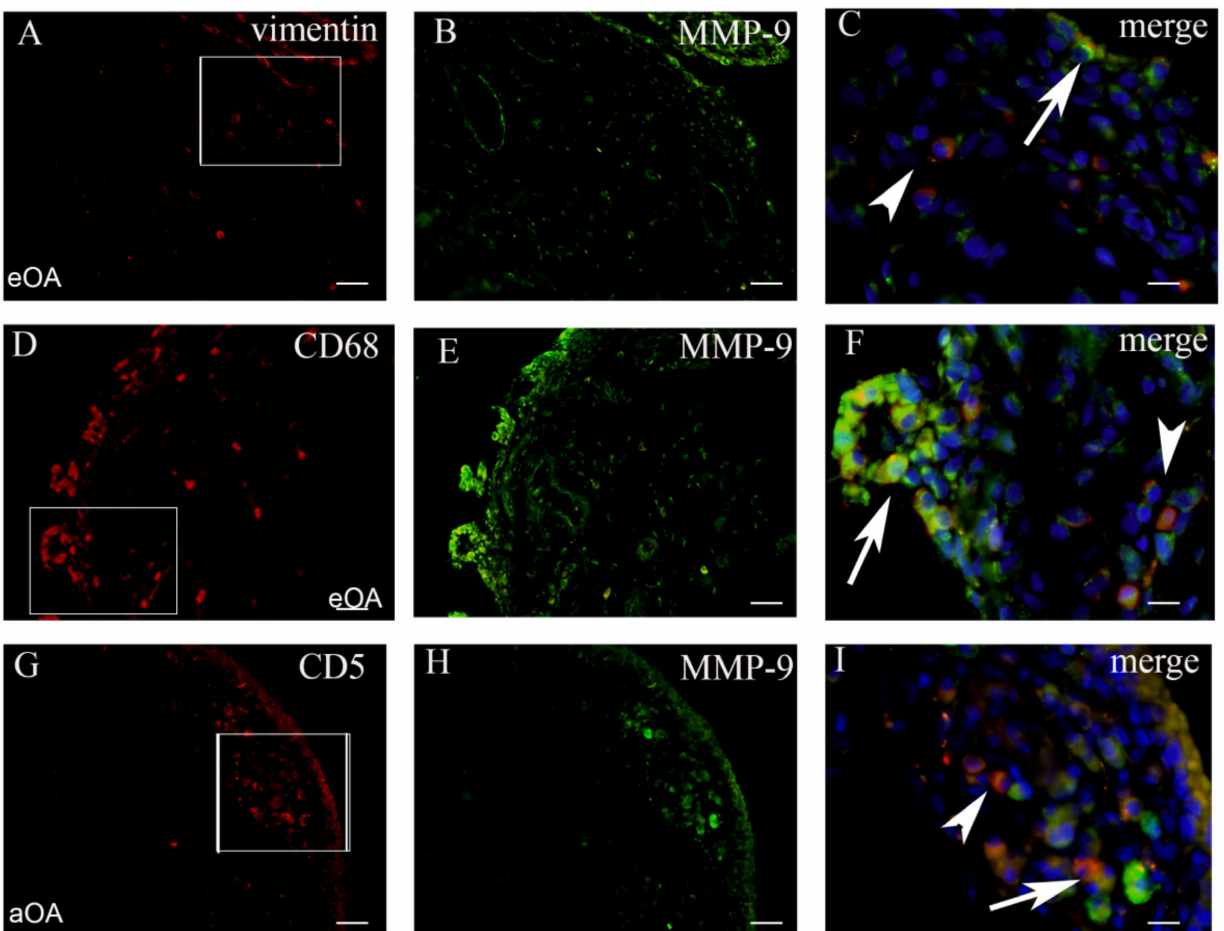
Figure 5. The synovial membrane of patients with early OA (eOA) ( A – C ). Vimentin positive (red) fibroblasts in the intima and subintima (frame). MMP-9 positive cells (green) in the synovial intima and subintima ( B ). The merge of DAPI (blue) nuclear stain+vimentin+MMP-9 (magnification of the frame in panel ( A )) show numerous fibroblasts in the intima co-localized with MMP-9 and vimentin (arrow), while the subintima displayed vimentin positive fibroblasts (arrowhead) ( C ). The synovial membrane of patients with early OA (eOA) ( D – F ). CD68 positive (red) macrophages in the intima and subintima (frame). MMP-9 positive cells (green) in the synovial intima and subintima ( E ). The merge of DAPI. (blue)+CD68+MMP-9(magnification of the frame in panel ( D )) show numerous macrophages in the intima co-localized with MMP-9 and CD68 (arrow), while the subintima displayed CD68 positive macrophages(arrowhead) ( F ). The synovial membrane of patients with advanced OA (aOA) ( G – I ). CD5 positive (red) lymphocytes in the subintima (frame). MMP-9 positive cells (green) in the synovial intima and subintima ( H ). The merge of DAPI (blue)+CD5+iNOS (magnification of the frame in panel ( G )) show the co-localization of MMP-9 and CD5 (arrow), while lymphocytes occasionally display only CD5 (arrowhead) ( I ). Magnification × 40 (first two columns), scale bar 25 µ m and × 100 (last column), scale bar 10 µ